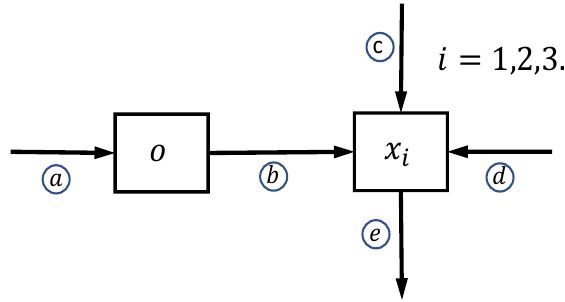
Figure 1. Conceptual diagram of the mathematical model. The state variables o , x 1 , x 2 , and x 3 represent the DO concentrations in the water and the AM populations—intolerant, regularly tolerant, and tolerant to organic contamination, respectively. The processes are: (a) oxygenation/aeration, (b) DO consumption, (c) AM natality, (d) DO utilization, and (e) interspecific